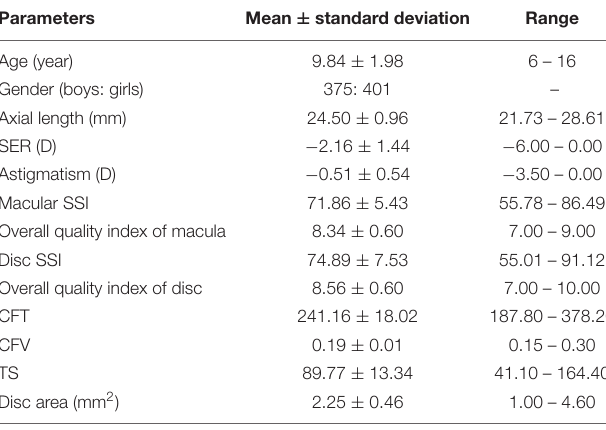
TABLE 1 | Characteristics of the eyes, macular VD, and disc VD in the children studied.